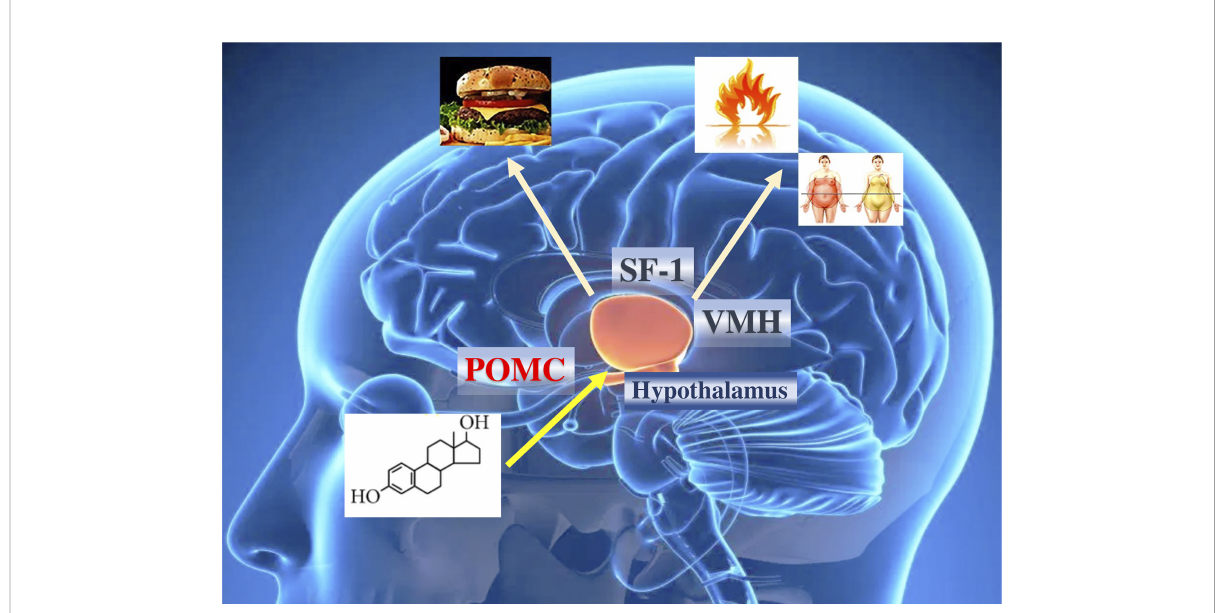
FIGURE 3 Effects of estrogens on hypothalamic and obesity control. ER a in the brain regulates body weight in both men and women. ER a in female SF1 neurons regulates energy expenditure and fat distribution. ER a in female POMC neurons regulates food intake. The effect of estrogens ultimately in fl uences caloric expenditure, body composition, and food intake. POMC, pro-opiomelanocortin; SF1, steroidogenic factor